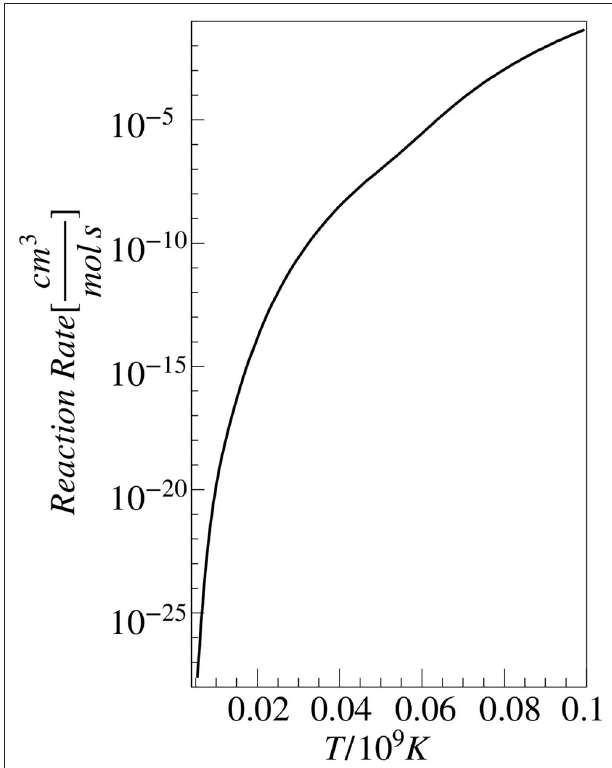
FIGURE 7 | Reaction rate of the 18 O( p , α ) 15 N